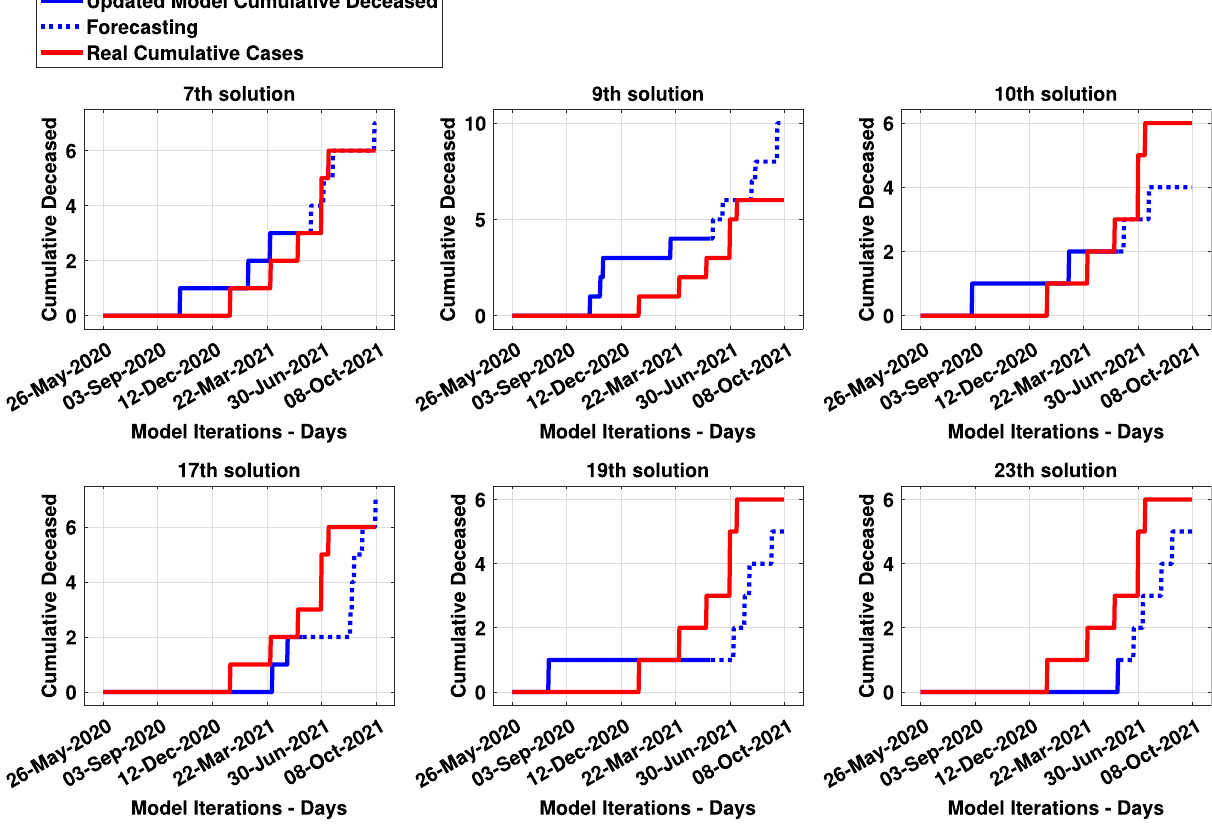
Figure 11. Updated model and real cumulative deceased curves.